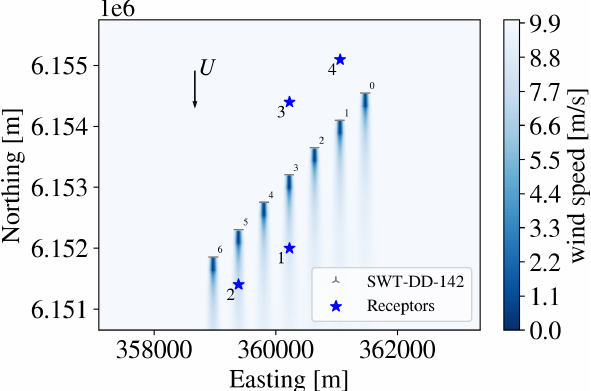
Figure 7. The flow field at hub height through the row of seven SWT-DD-142 wind turbines at the wind direction θ = 0 ◦ . The dis- tances between the turbines are scaled to be approximately 4.3 D